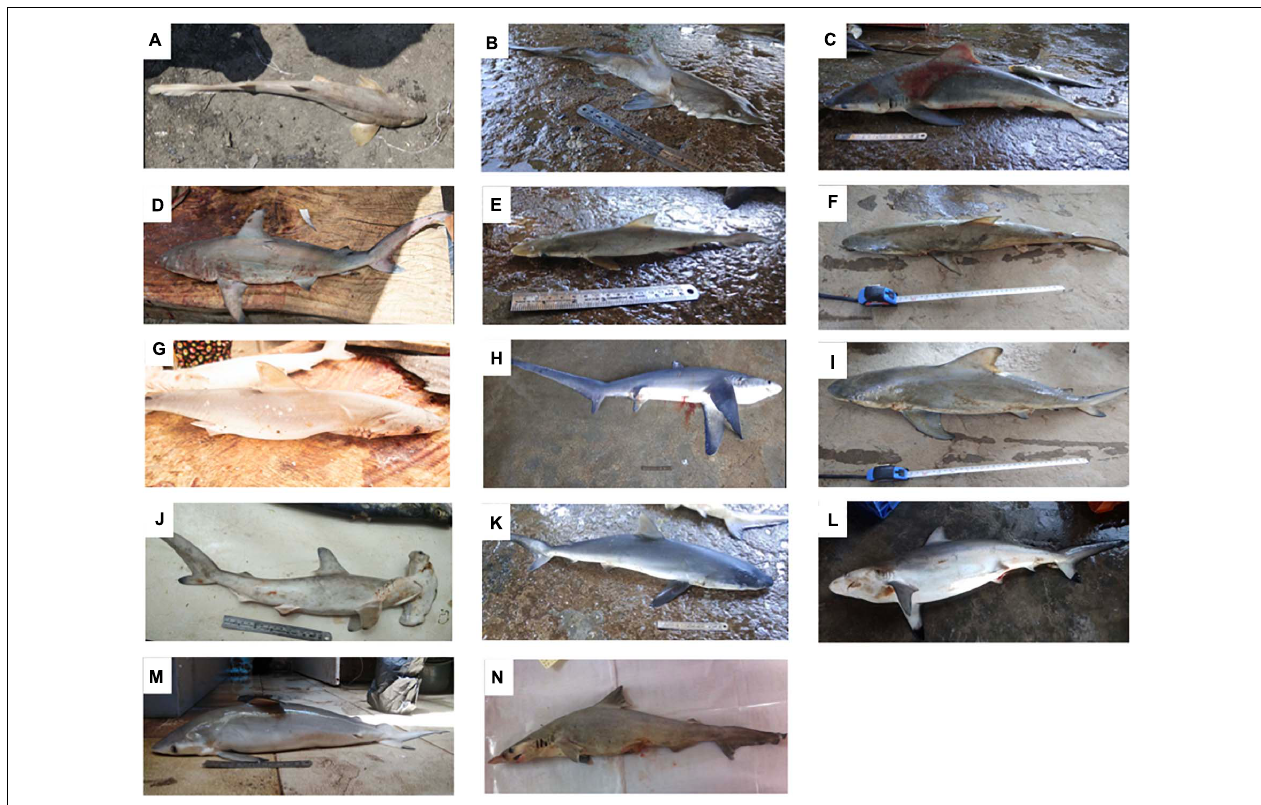
FIGURE 2 | Representative pictures of species sampled in the superorder Selachimorpha. (A) Chiloscyllium arabicum (Arabian carpetshark), (B) Iago omanensis (Bigeye houndshark), (C) Carcharhinus leucas (Bull shark), (D) Carcharhinus limbatus (Common Blacktip shark), (E) Rhizoprionodon oligolinx (Gray Sharpnose shark), (F) Carcharhinus macloti (Hardnose shark), (G) Rhizoprionodon acutus (Milk shark), (H) Alopias pelagicus (Pelagic Thresher shark), (I) Carcharhinus amboinensis (Pigeye shark), (J) Sphyrna lewini (Scalloped Hammerhead), (K) Carcharhinus falciformis (Silky shark), (L) Scoliodon laticaudus (Spadenose